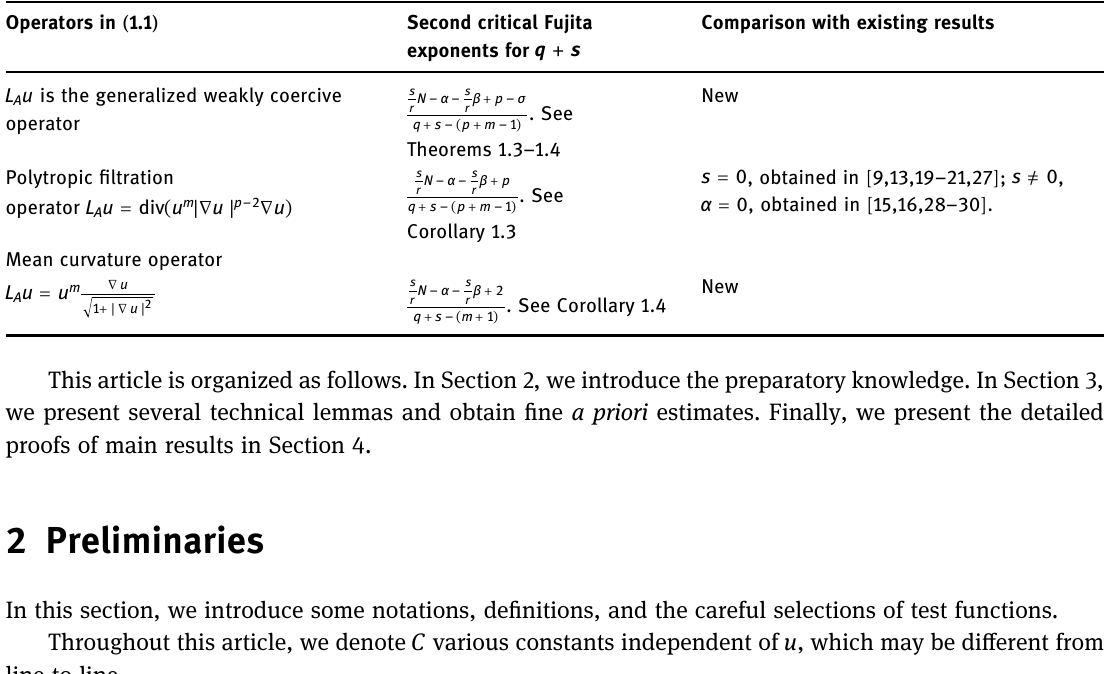
Comparison with existing s